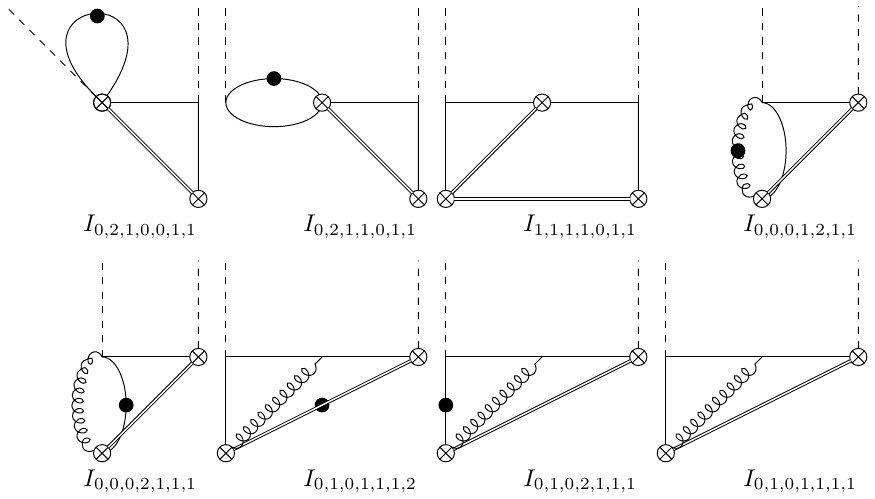
Figure 8. The pre-canonical master integrals for the virtual corrections to D t → H